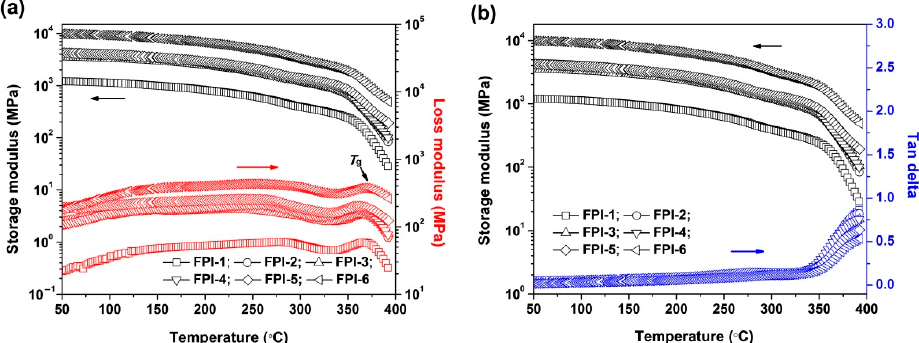
Figure 8. DMA plots of FPI films: ( a ) storage modulus and loss modulus; ( b ) storage modulus and tan delta.